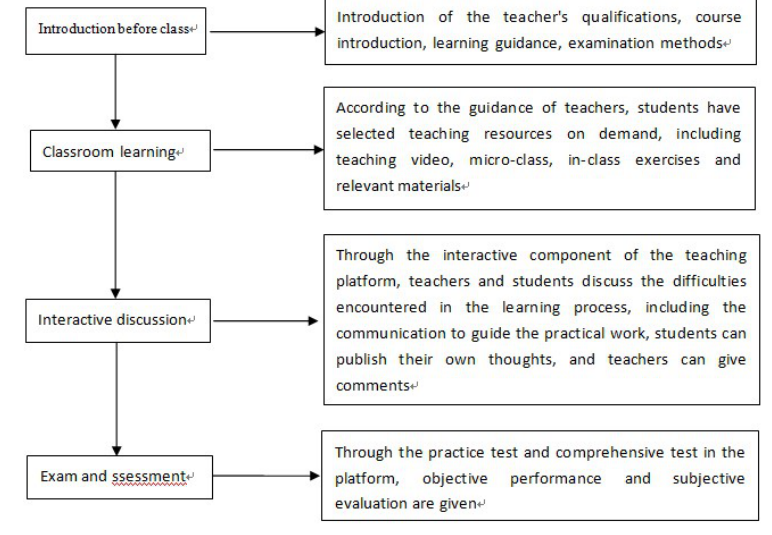
Figure 2. Basic modules of the teaching